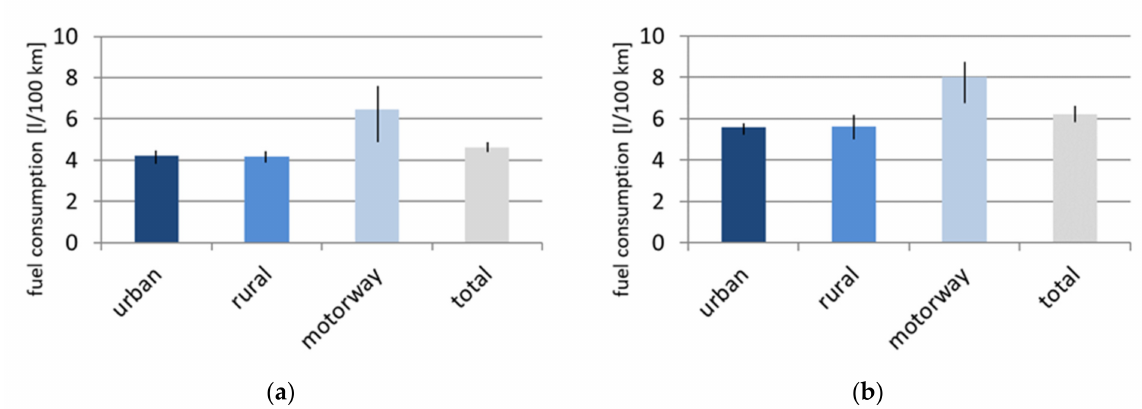
Figure 4. Influence of driving mode on the real-world fuel consumption of the studied plug-in hybrid electric vehicle (PHEV) during summer time. ( a ) Hybrid driving mode; ( b ) Sport driving mode.